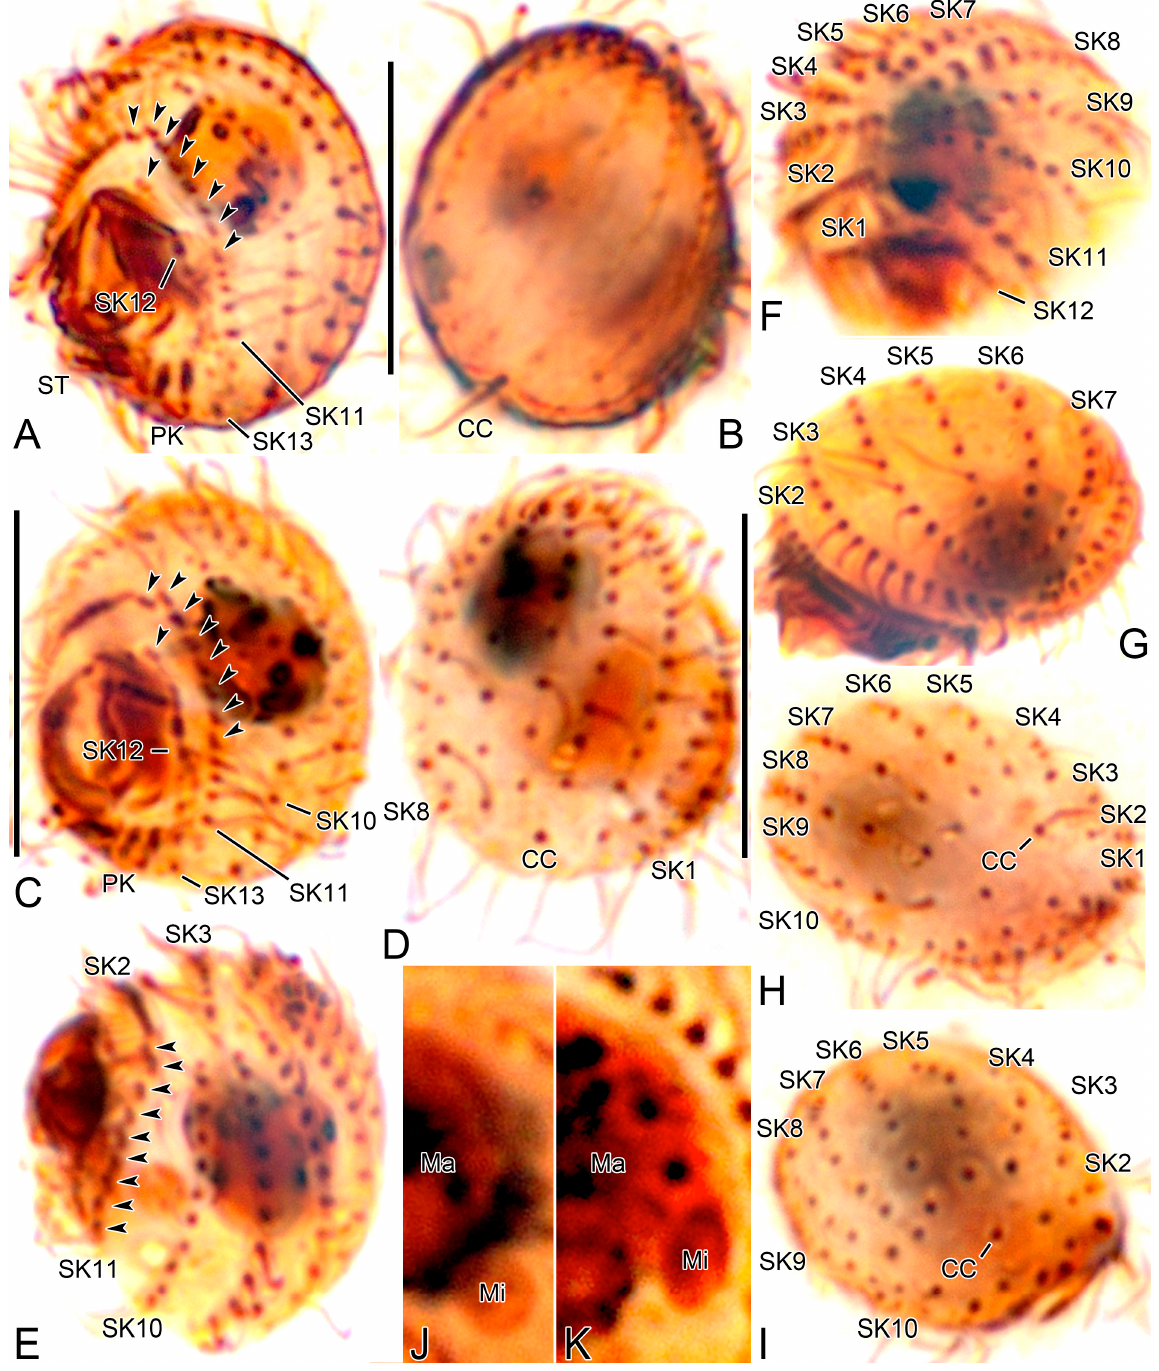
Figure 4. Cinetochilides minimus sp. nov. after protargol impregnation. ( A , B ). Ventral ( A ) and dorsal ( B ) view of the holotype specimen. Arrowheads denote dikinetids in somatic kineties 11 and 12. Note that the caudal cilium has an ordinary length. ( C – I ). Ventral ( C ), dorsal ( D ), left lateral ( E ), apical ( F , G ), and posterior polar ( H , I ) views, showing the body shape and ciliatures. Arrowheads mark the dikinetids in somatic kineties n-2 and n-1. ( J , K ). Nuclear apparatus. CC, caudal cilium; Ma, macronuclear nodules; Mi, micronuclei; PK, postoral kineties; SK, somatic kineties; ST, scutica. Scale bars: 10 µ